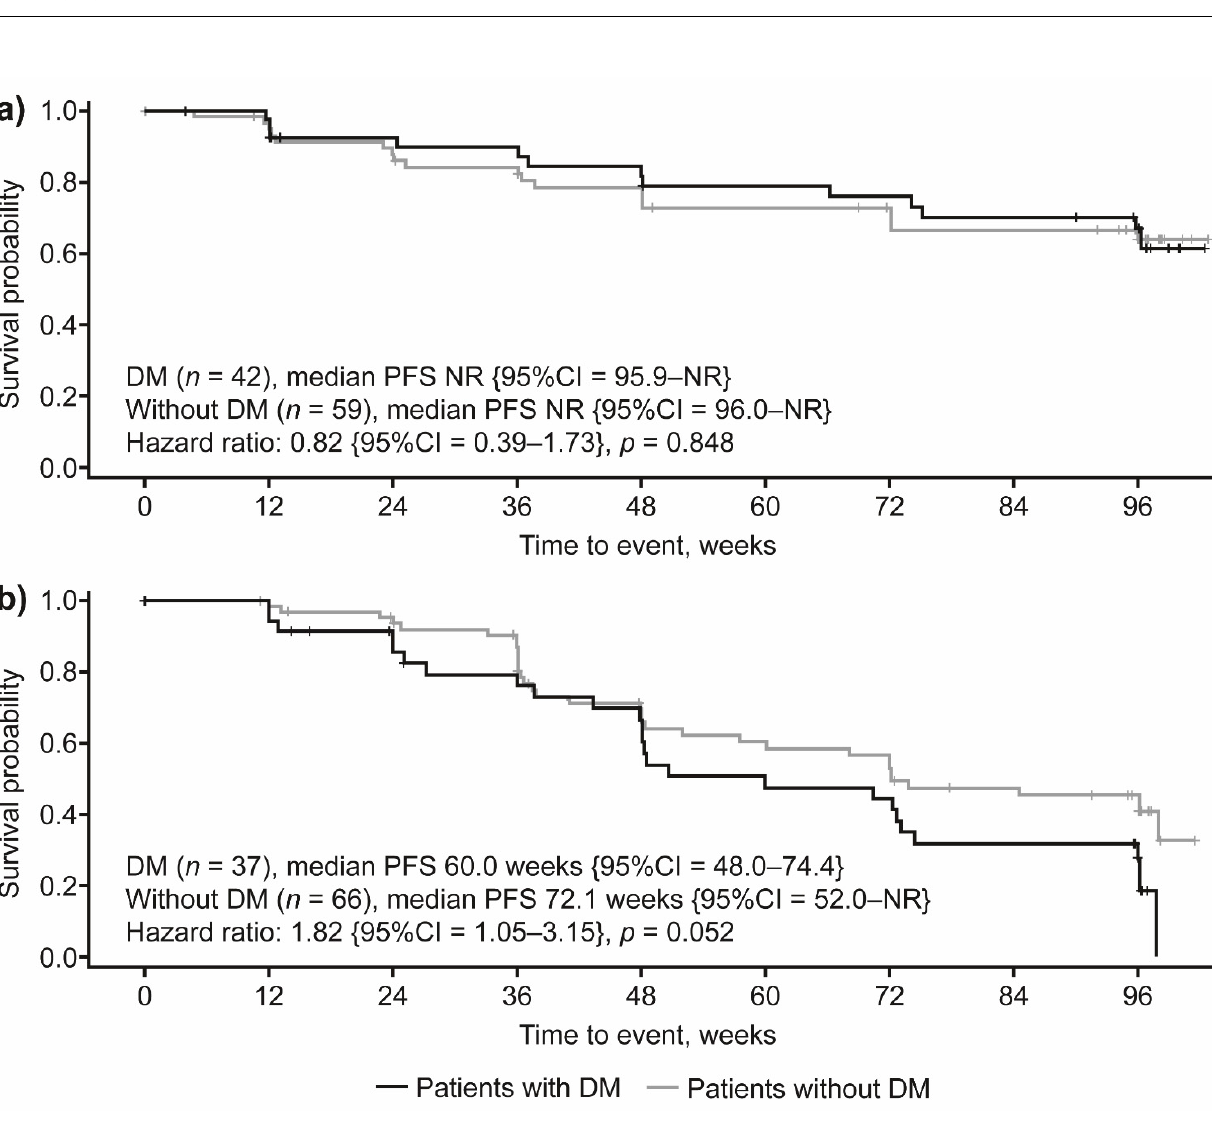
Figure 3. PFS by DM status in patients receiving ( a ) lanreotide 120 mg and ( b ) placebo.